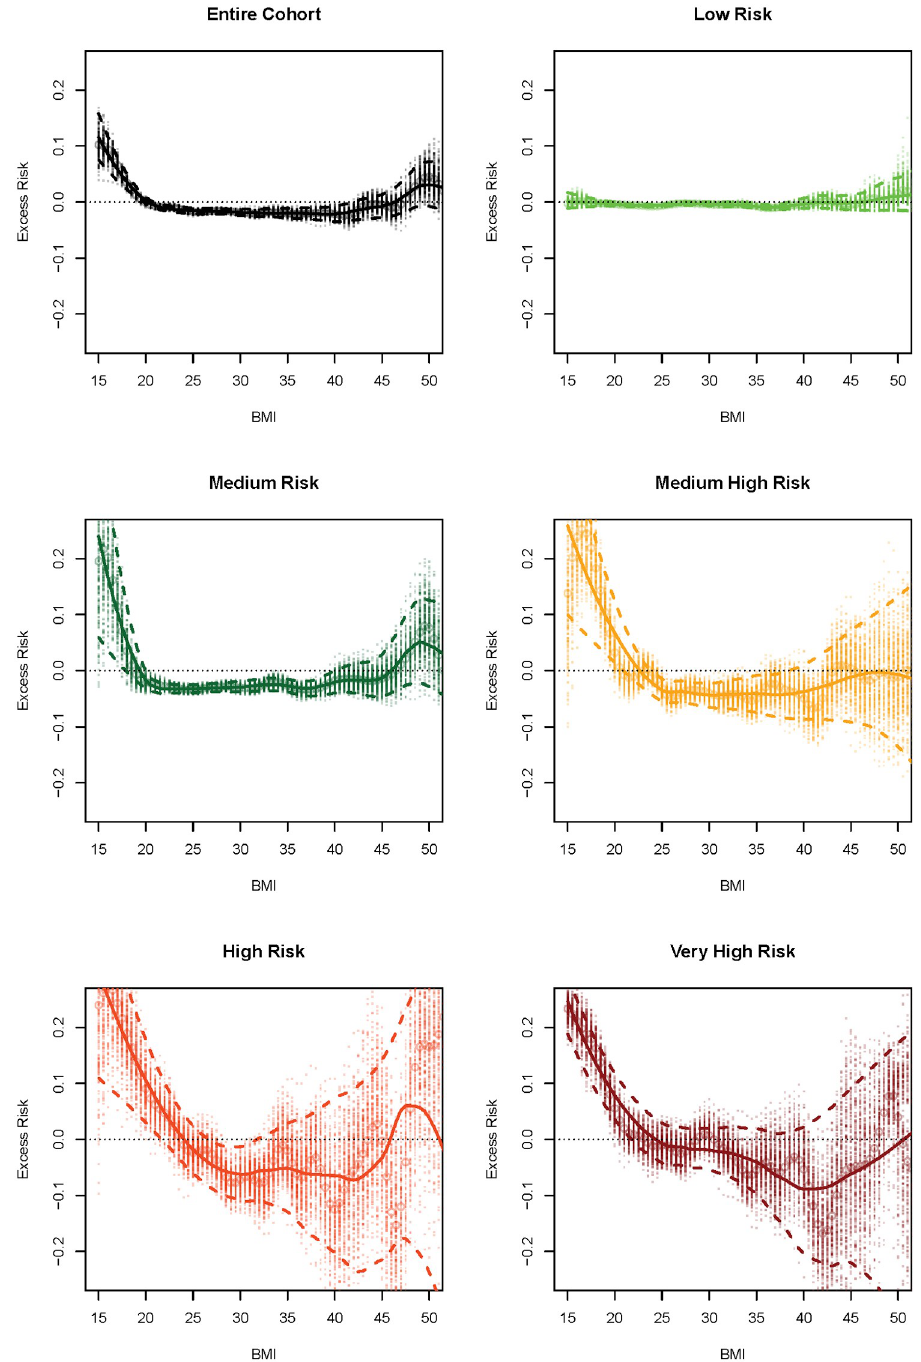
Fig 3. Excess risk of all-cause mortality attributed to the BMI not explained by the baseline comorbidities (residual risk) after adjusting for baseline mortality risk. The residual risk was estimated for each 0.5 Kg/m 2 BMI interval between 15 and 55. The dots represent the point estimates of the mortality rate in the 200 bootstrap iterations, circles are the mean, the solid line is a smooth curve representing the averages and the dashed lines are the 95% empirical confidence interval. Values above zero represent increase risk and values below zero represent decreased risk compared to the group average.